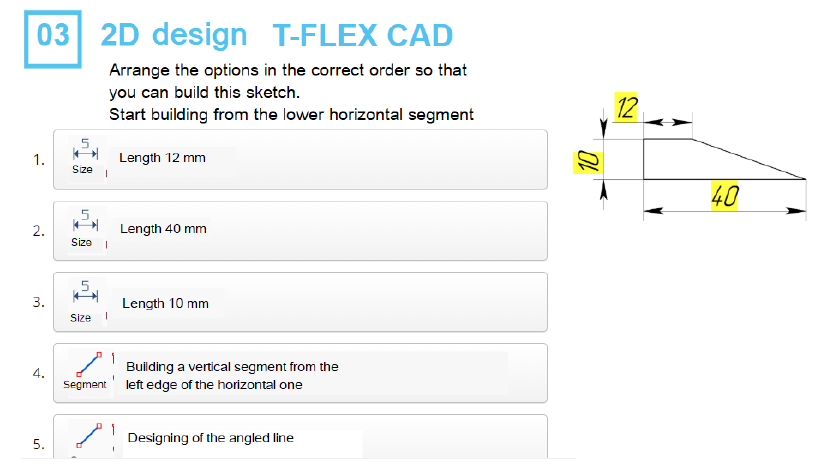
Fig. 9. Task for the sequence of